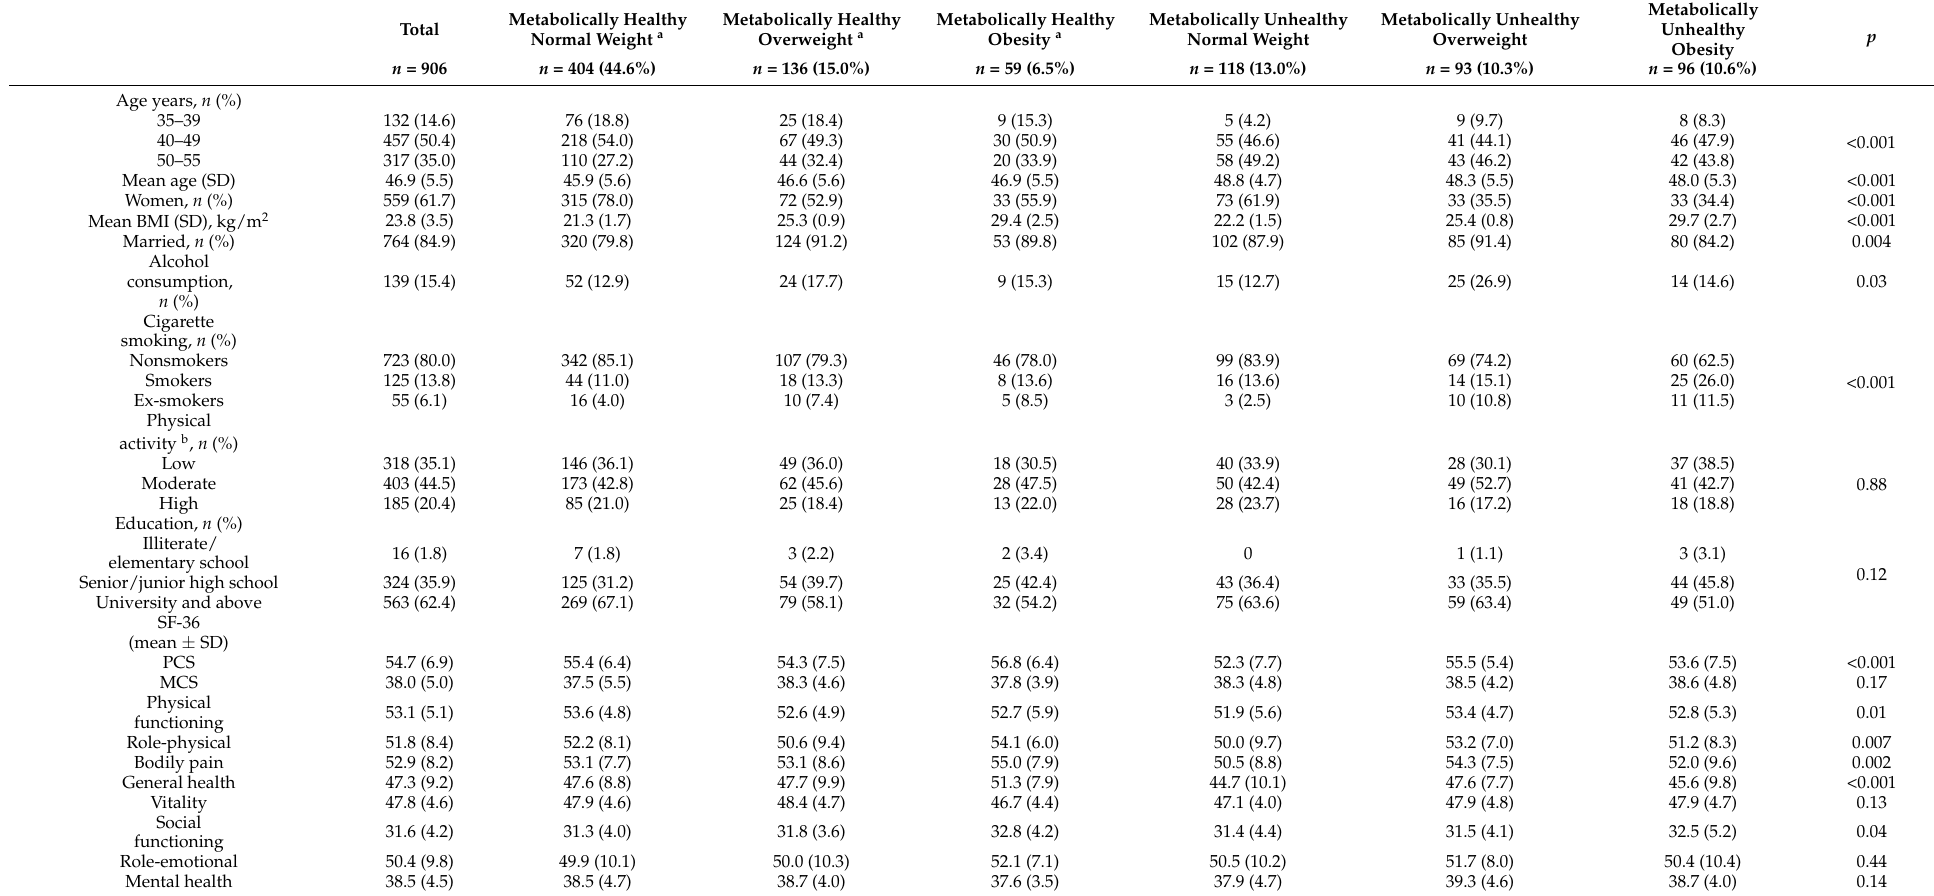
Table 1. Demographic characteristics of participants at baseline, classified by the metabolic health/BMI groups at